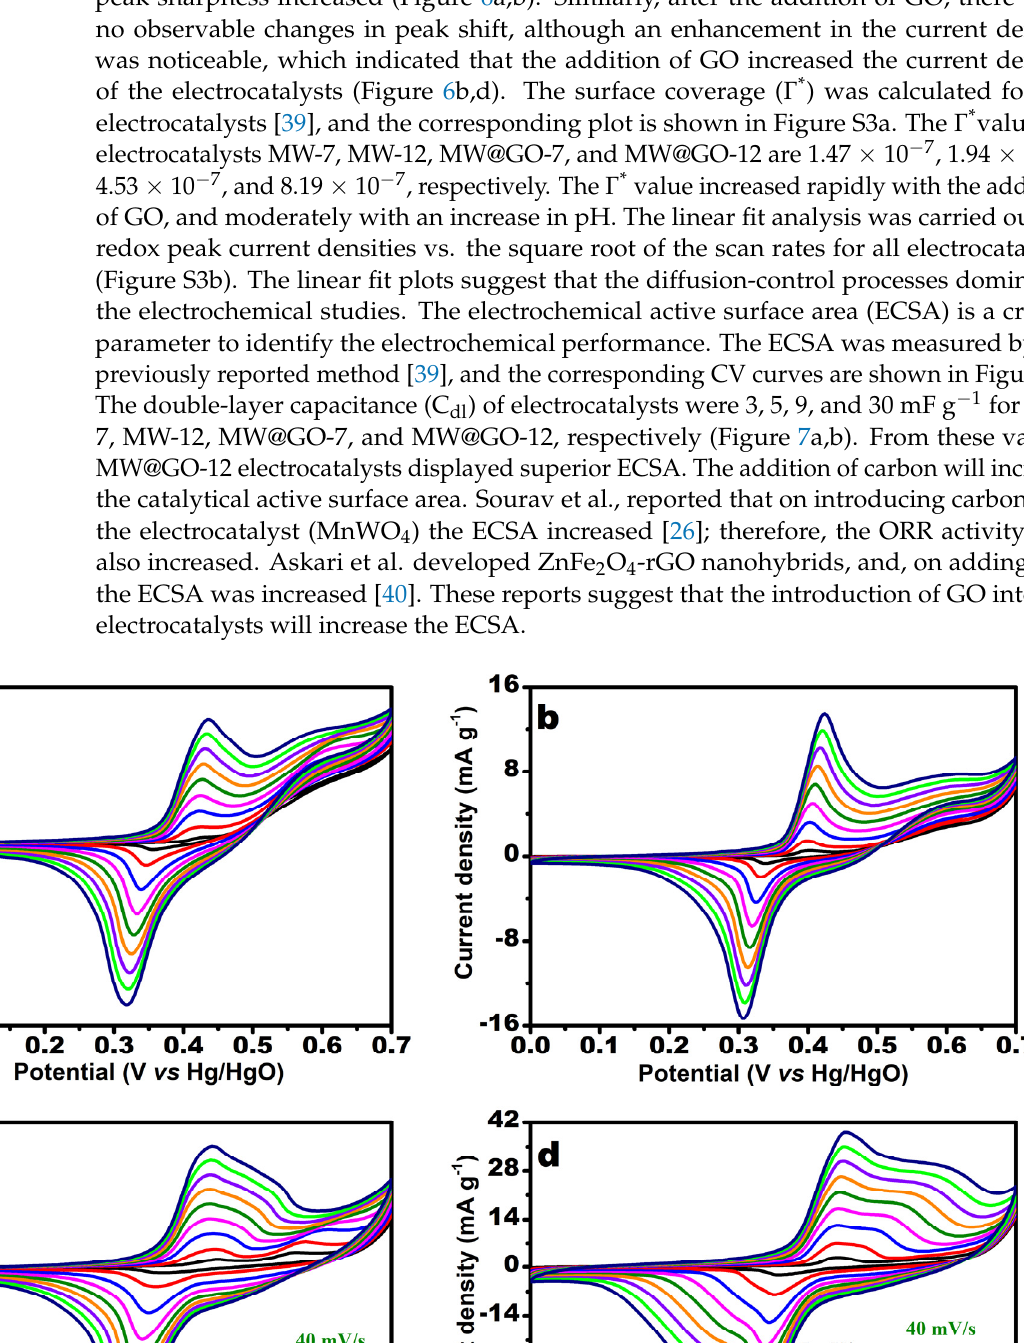
Figure 7. Comparative CV curves of the electrocatalysts for the ECSA analysis ( a ) and the corre- sponding electrochemical double-layer capacity linear fit plots of the electrocatalysts ( b ). The electro-oxidation of urea was performed using the electrocatalysts, and the re- sults are shown in Figure 8a–d, labeled MW-7, MW-12, MW@GO-7, and MW@GO-12, re- spectively. UOR was carried out at various scan rates (5–80 mV/s) and a fixed potential range (0.0–0.7 V). The current densities of MW-12 slightly increased compared to MW-7